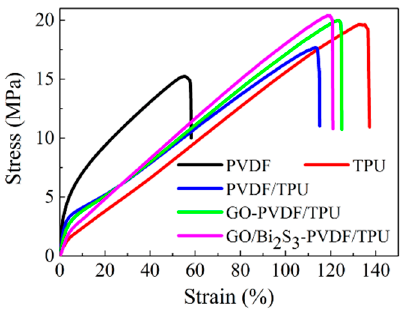
ff erent membranes.